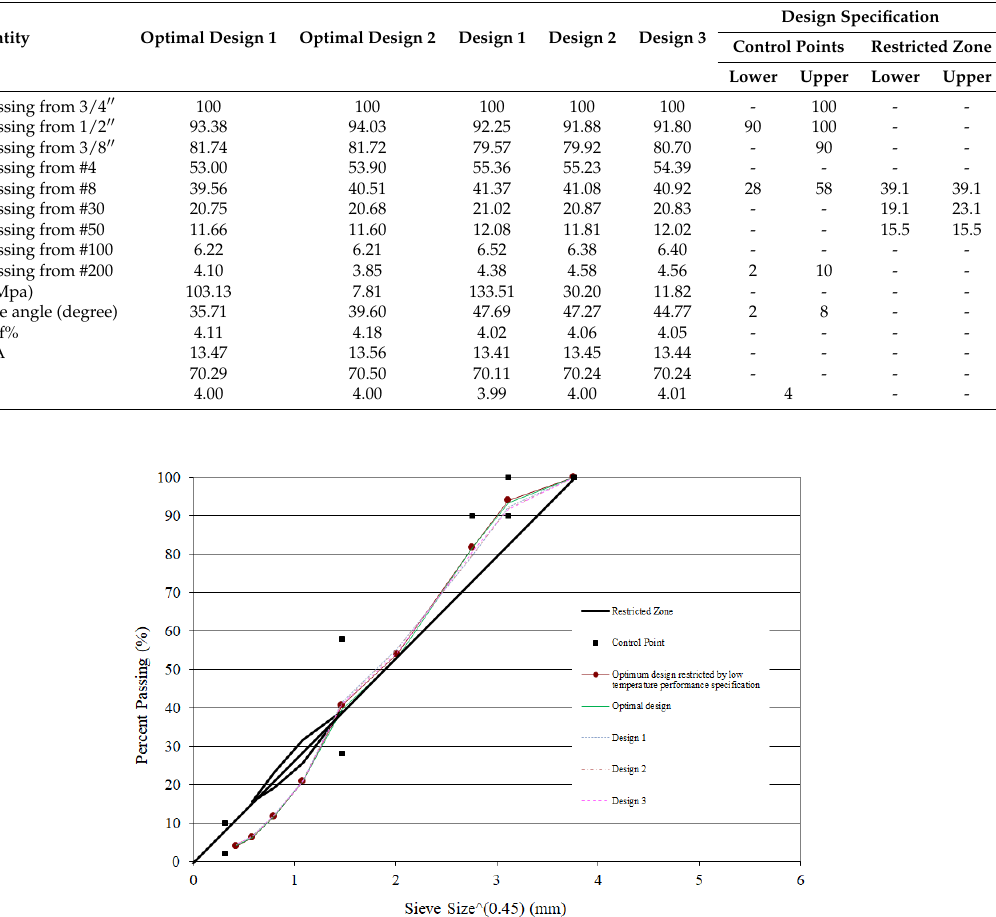
Figure 10. Convergence for the optimal design problem ( left ) and inverse ( right ) design of dynamic modulus. Table 7. Th Corresponding Design Parameters Obtained from Solving Optimal Design and Inverse Design Problems.